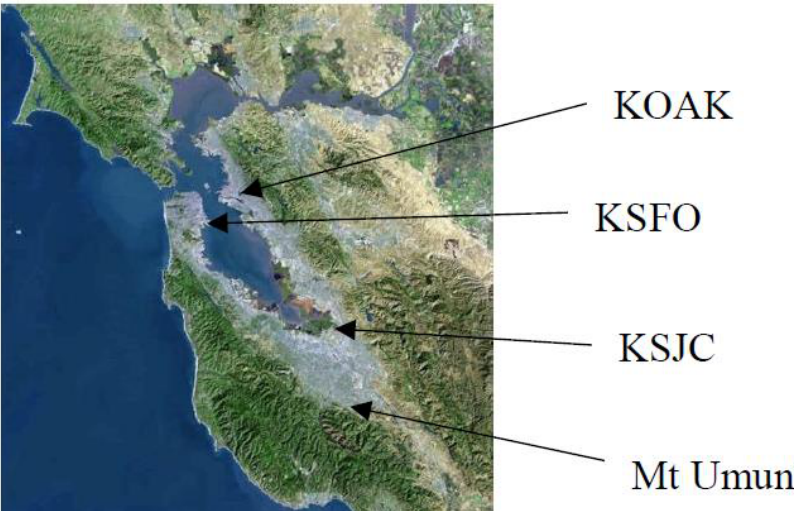
Figure 1. SFBA (San Francisco Bay Area) terrain features. Shown are locations of the three airports (KOAK, KSFO, KSJC—Oakland, San Francisco, San Jose), and the peak of Mt Umunhum where the NWS–Monterey radar is located. The Santa Clara Valley (SCV) is at the southern end of the Bay Area, with San Jose at its heart.